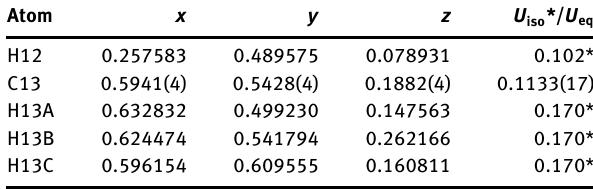
Table 2: Fractional atomic coordinates and isotropic or equivalent isotropic displacement parameters (Å 2